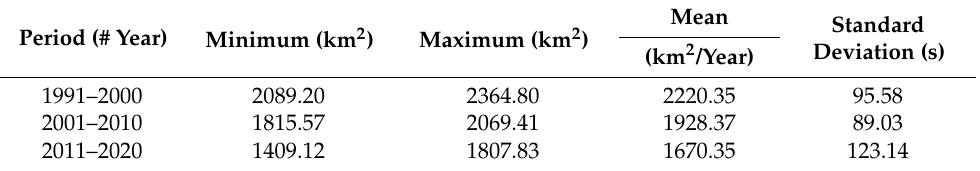
Table 1. Glacier-mapping summary statistics estimated for decennial periods.